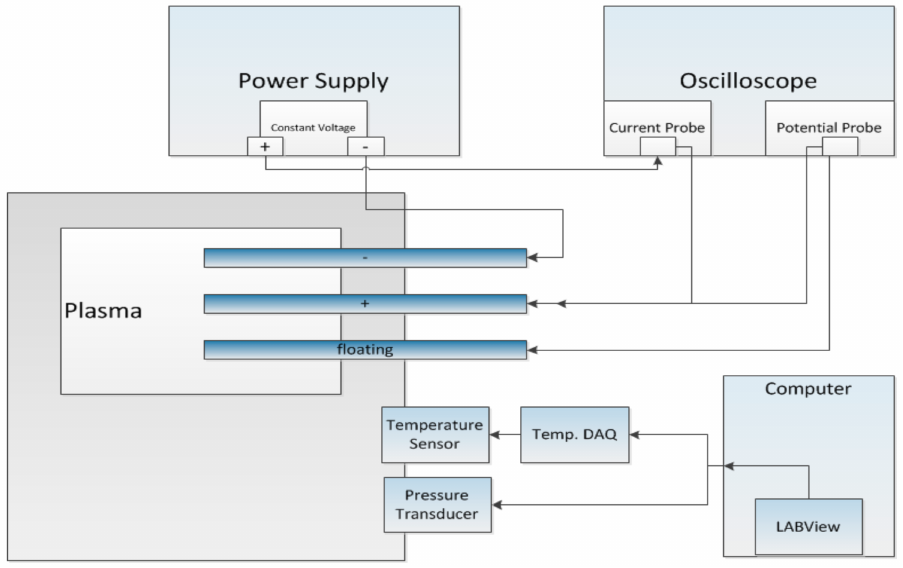
Figure 7. The instrumentation schematics.